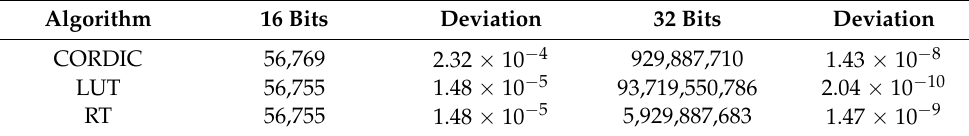
Table 2. Accuracy comparison of different algorithms to generate cosine